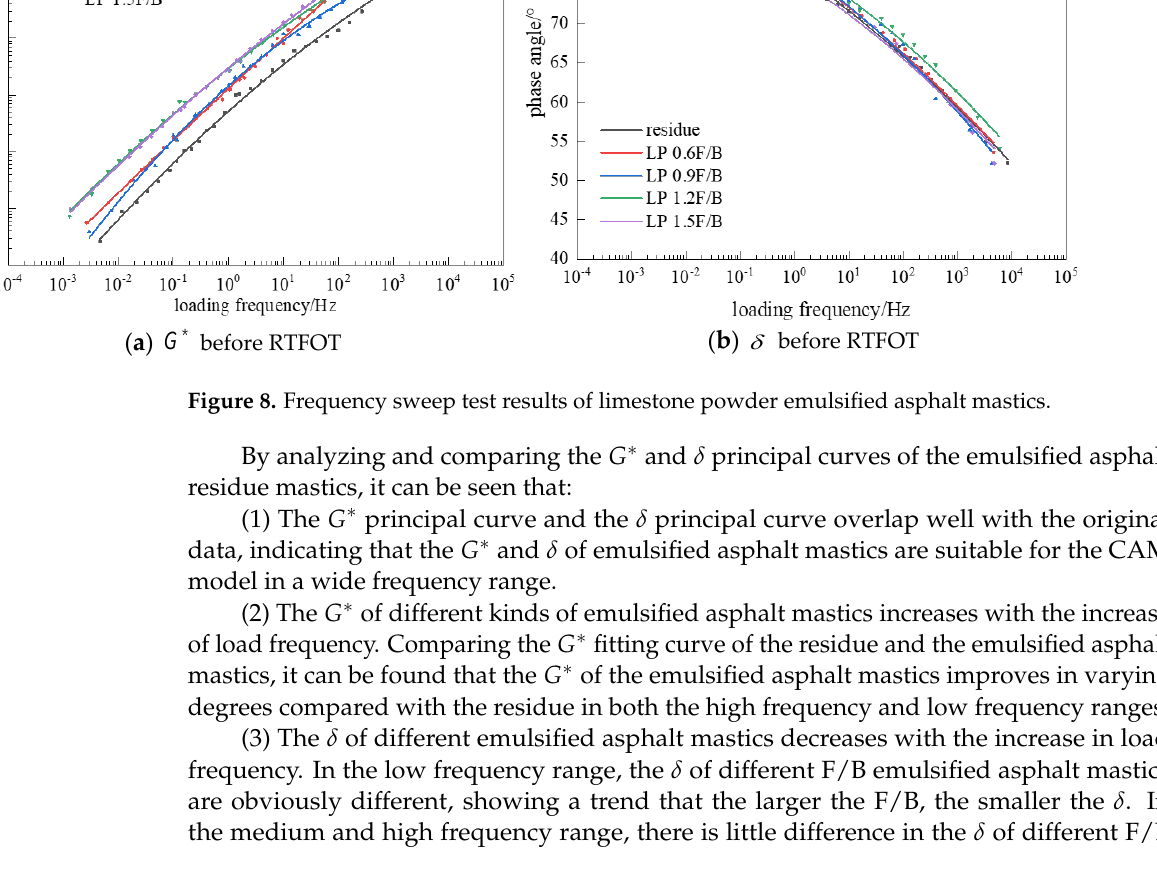
Figure 9. Frequency sweep test results of coal gangue powder emulsified asphalt mastics.